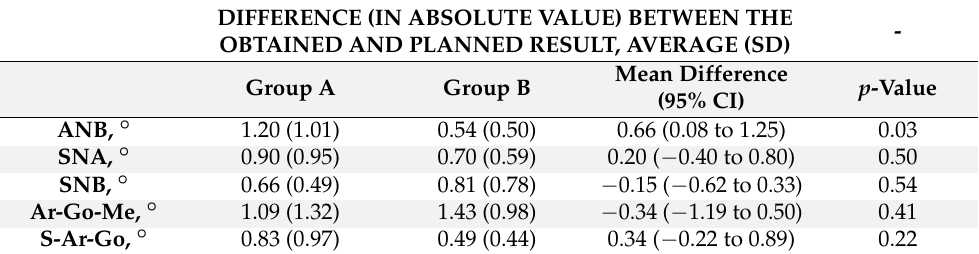
Table 4. Comparison between groups A and B. DIFFERENCE (IN ABSOLUTE VALUE) BETWEEN THE OBTAINED AND PLANNED RESULT, AVERAGE (SD)